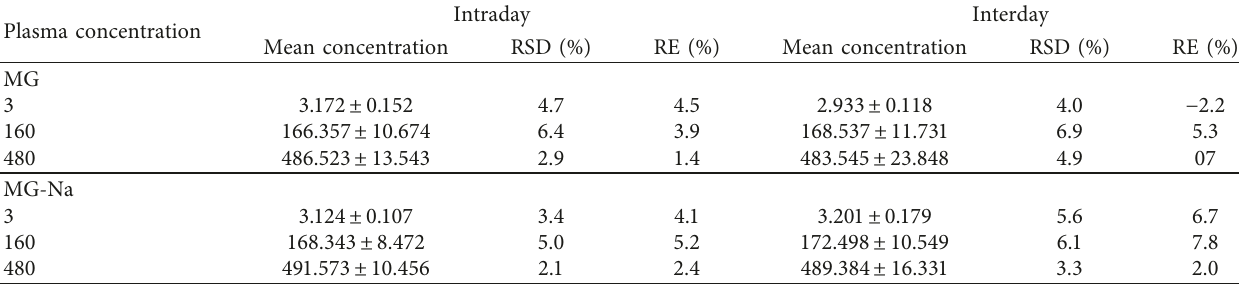
Table 1: Precision and accuracy of MG and MG-Na in rat plasma ( x ± s ng/mL).